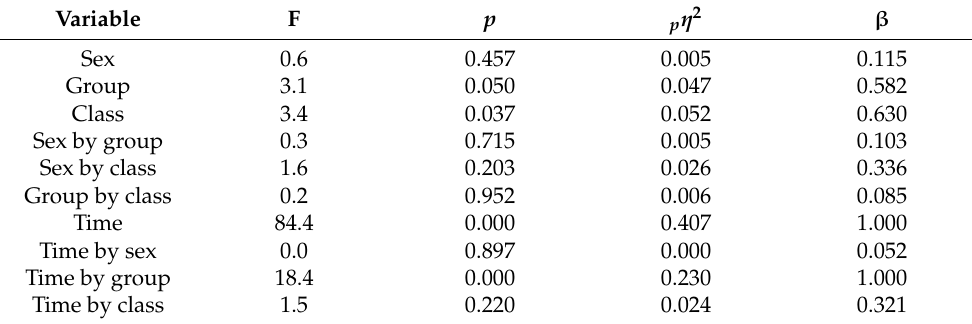
Figure 2. SCWT (time) results. * significant differences. Table 3. SCWT test results.